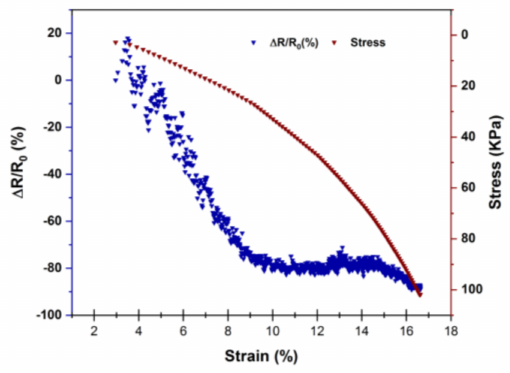
Figure 3. Piezoresistive responses of 1% MWNT nanocomposite 3D-printed layers under com- pressive